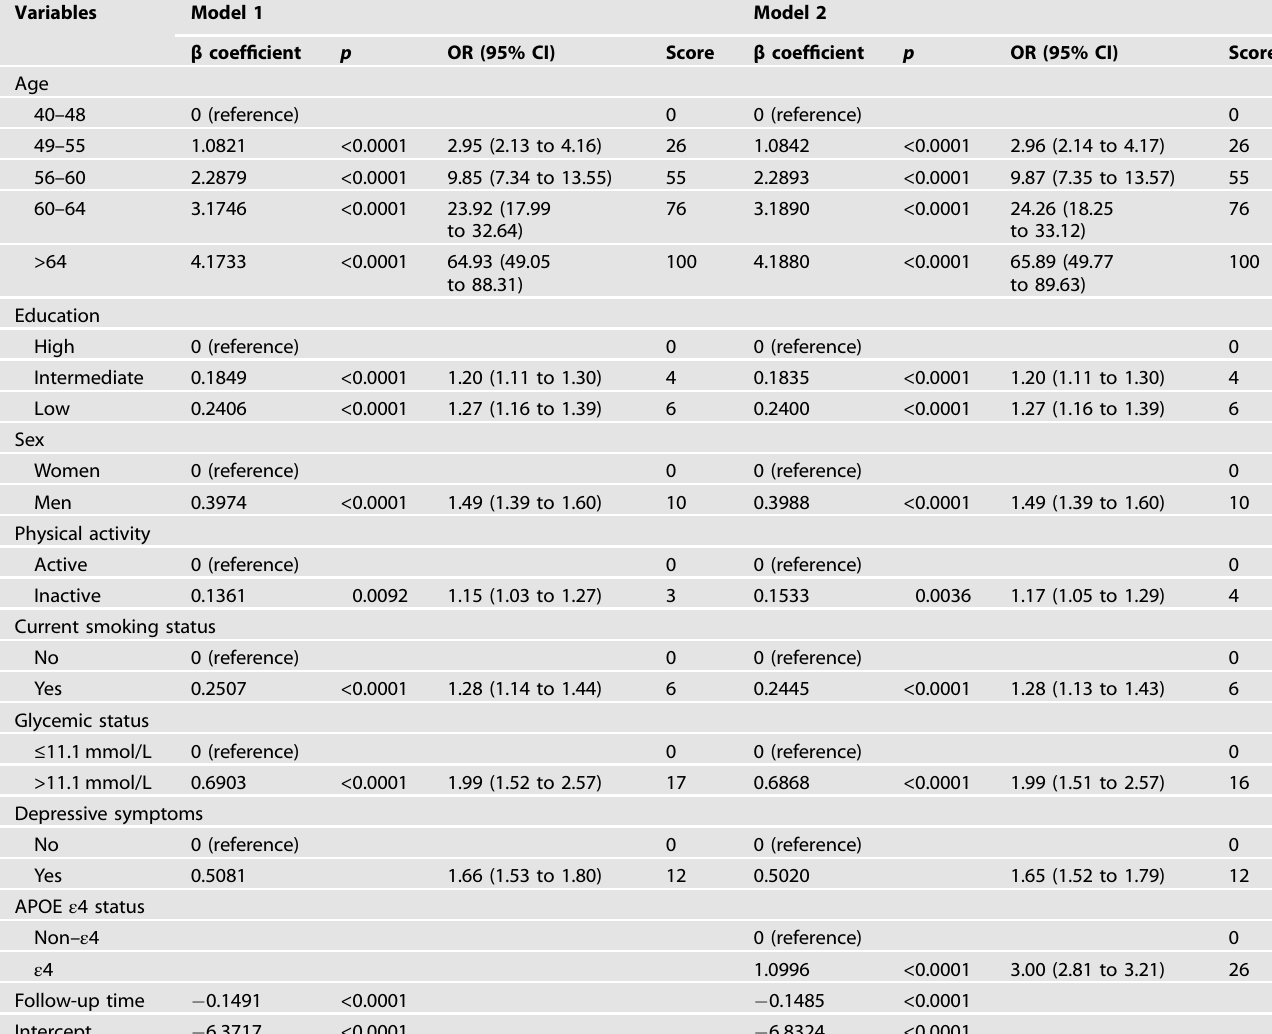
Table 2. Logistic regression models for dementia risk, according to the risk factor pro fi les at middle age and the risk scores derived from the β coef fi